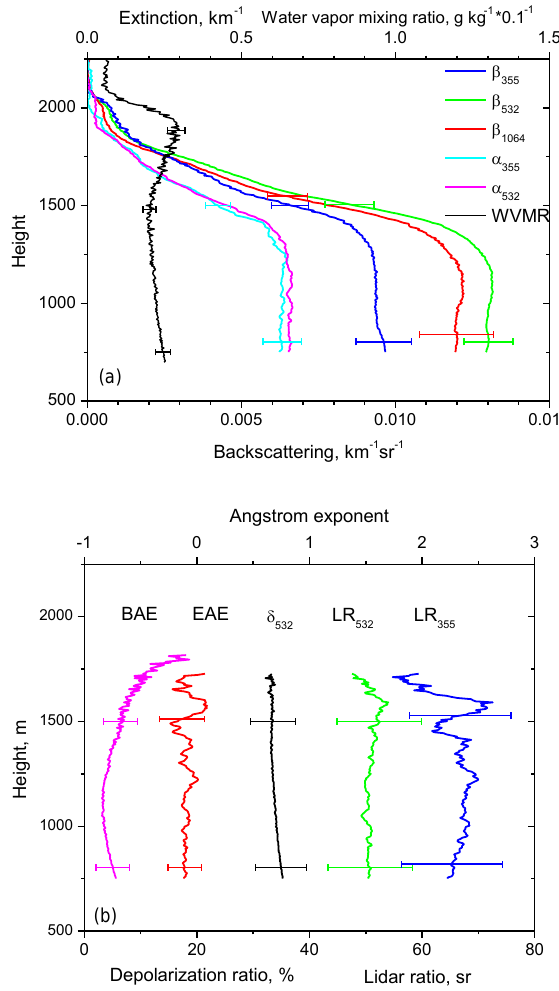
Figure 12. Vertical profiles of (a) backscattering and extinction co- efficients and (b) lidar ratios, depolarization ratio, and backscatter- ing and extinction Ångström exponents at 355/532nm measured on 29 March 2015 for the period of